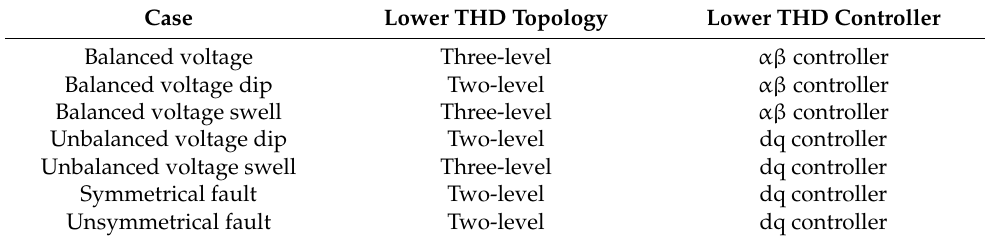
Table 6. Results